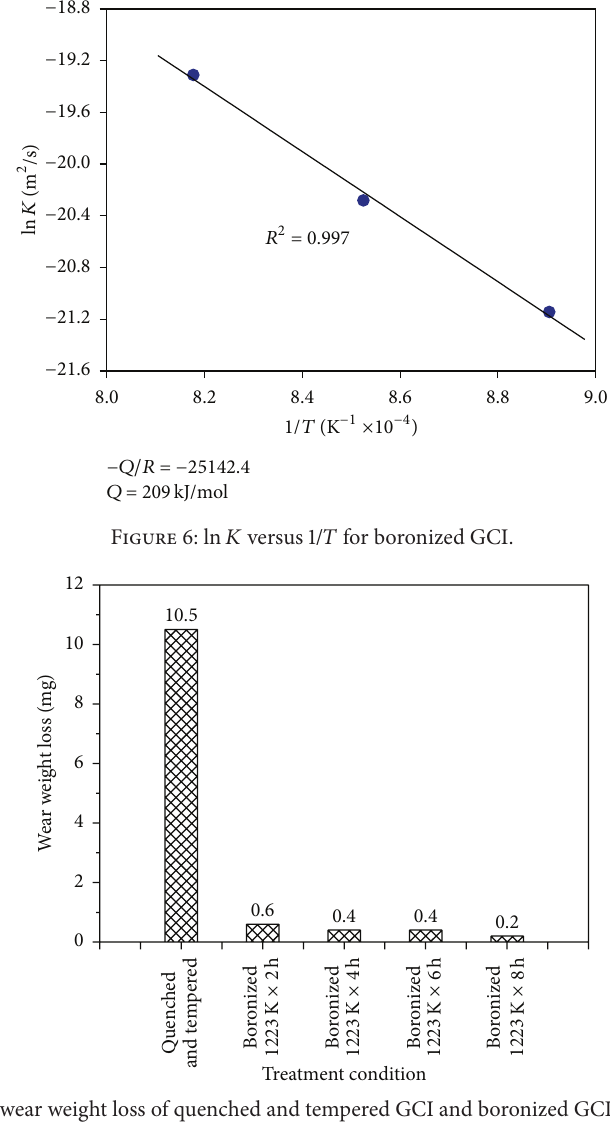
Figure 7: The figure shows the wear weight loss of quenched and tempered GCI and boronized GCI at 1223K through the wear tests. boride formed on GCI has tooth-shaped morphology. More- over, three distinct regions are identified on cross-sections of boronized GCI surface. These are (1) a surface